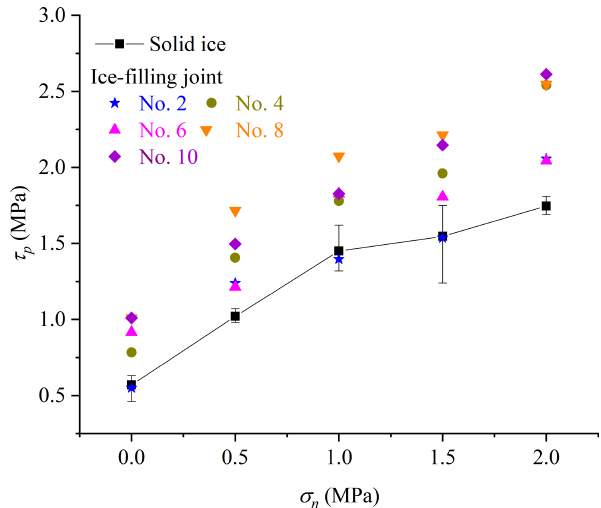
Figure 23. Shear failure characteristics of ice–rock inter- faces under different normal stress. Experimental conditions: v = 0.2mmmin − 1 , d = 2mm and T =− 15 ◦